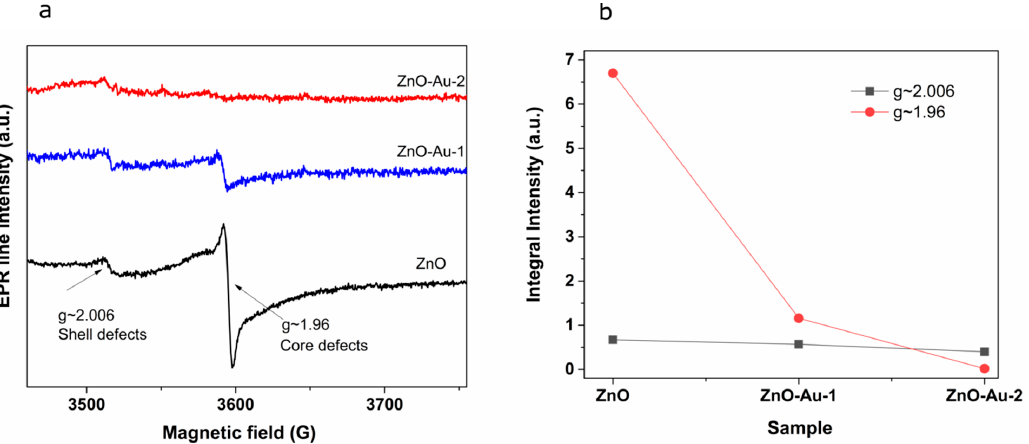
Figure 9. EPR spectra of ZnO nanoparticles and ZnO-Au nanocomposites ( a ); the integral intensity of the resonance signal ( b ).